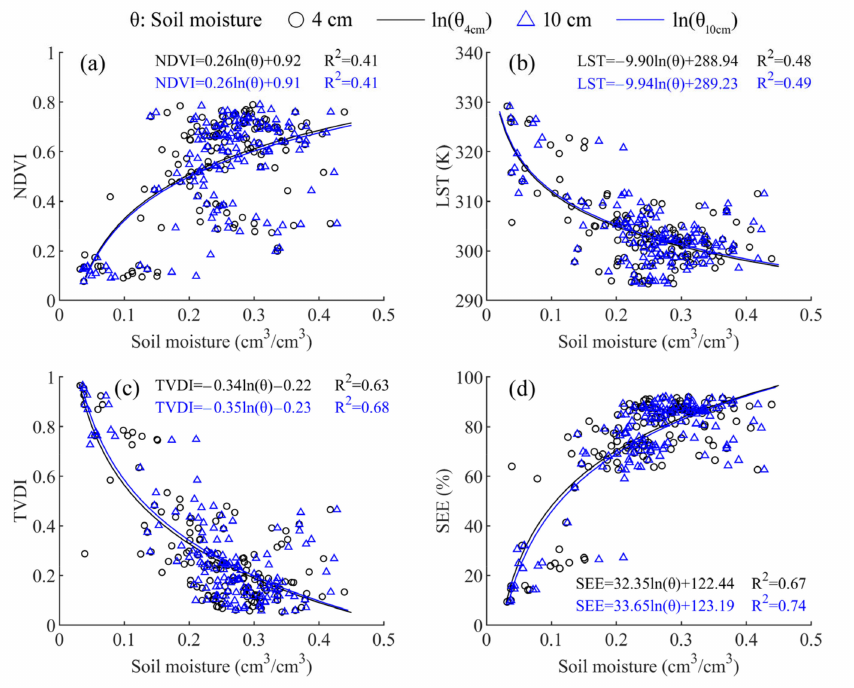
Figure 5. The scatter plots of four auxiliary variables and soil moisture at 4 cm (black) and 10 cm (blue). ( a – d ) represent the correlations and fitting relationships between NDVI, LST, TVDI, SEE and soil moisture,